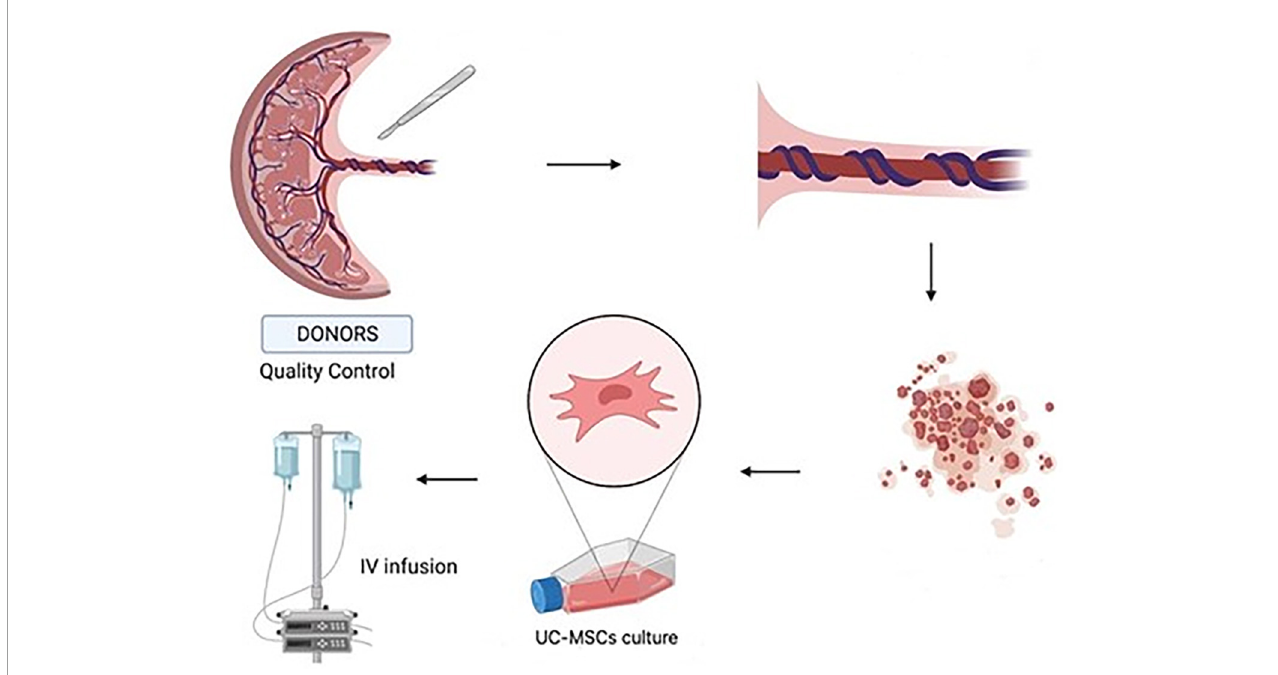
FIGURE1 Umbilical cord tissue was used to isolate umbilical cord-mesenchymal stem cells (UC-MSCs) by primary culture. UC-MSCs obtained from the placenta were dissected into 1–2 mm pieces. They were cultured and amplified. The cell suspensions are administered intravenously to the patients (Created with